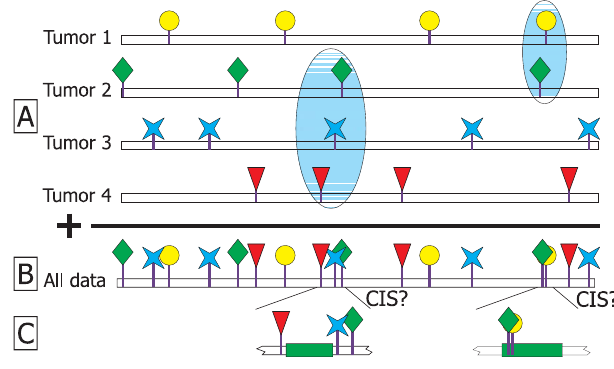
Figure 1. Schematic View of Insertion Data (A) Schematic view of the mapped data of four tumors. Significance is determined by the number of tumors which contain insertions in a particular region. The geometric symbols represent the insertions and are given a different shape for each tumor. The blue regions indicate possible CISs. (B) When considering a broad region, the number of insertions one would expect to have occurred by chance is higher, and hence the regions need to be hit in more independent tumors than for narrow regions before significance is reached. (C) Genes (indicated by the green bars) may be affected from various loci around or within the gene, and there does not exist one distance over which viral inserts act on their targets.